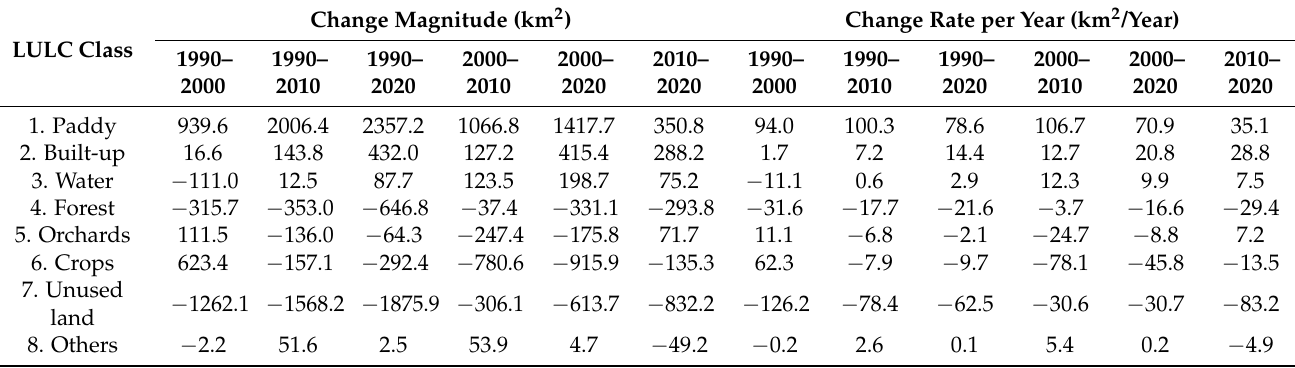
Table 6. The magnitudes and annual rate changes for the LULC classes in the Dong Thap Muoi area for the period 1990–2020. LULC